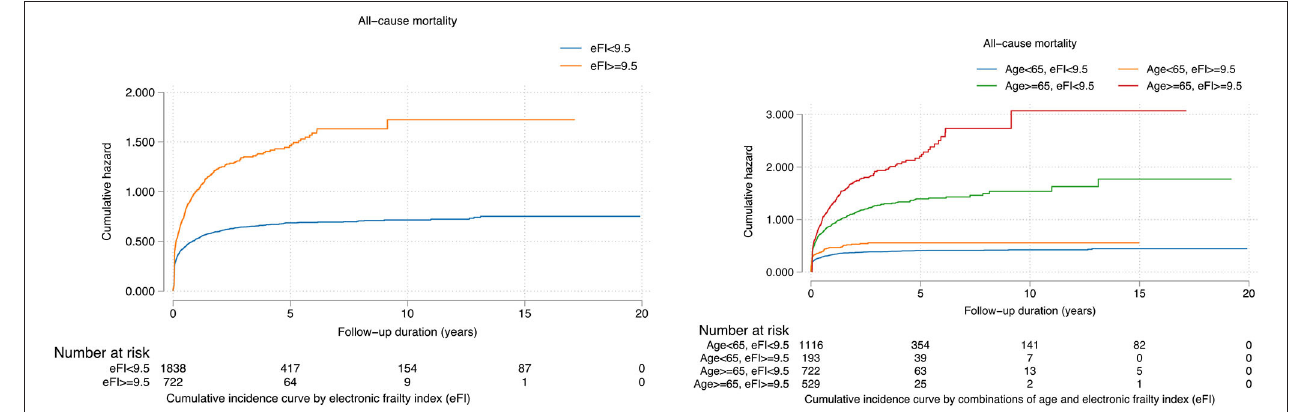
FIGURE 4 | Cumulative incidence curves for all-cause mortality stratified by the constructed electronic frailty index and age. TABLE 3C | Prediction strength of the constructed electronic frailty index for mortality risks within 2-year follow-up, 5-year follow-up, 10-year follow-up, 15-year follow-up, and 20-year follow-up.